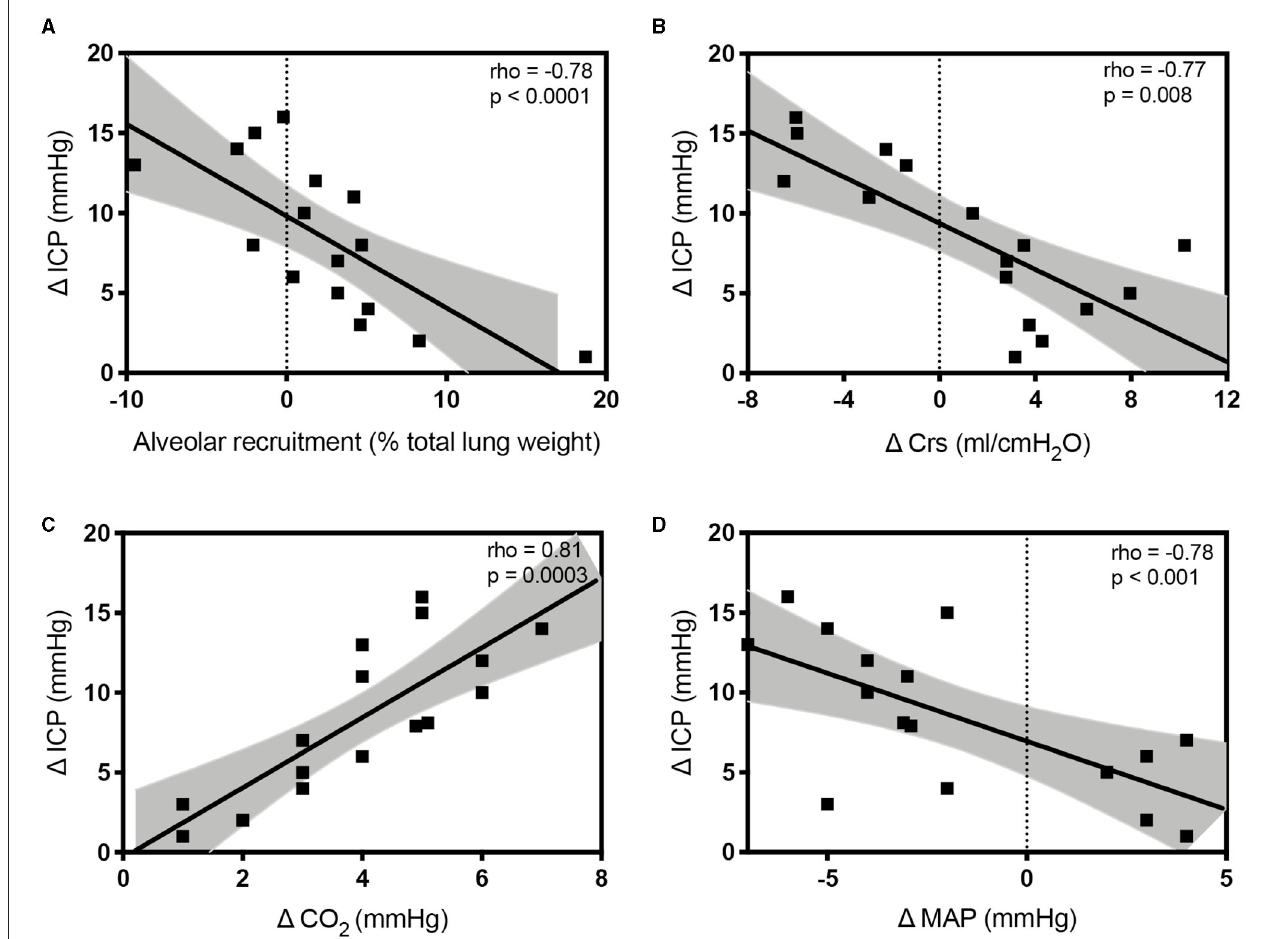
FIGURE 4 | Scatterplots showing the linear association and correlation between alveolar recruitment (A) , 1 respiratory system compliance (Crs; B ), 1 carbon dioxide (PaCO 2 ; C ), 1 mean arterial pressure (MAP; D ) vs. 1 intracranial pressure (ICP) at different study time points. Dotted lines represent the 95% CIs for the linear